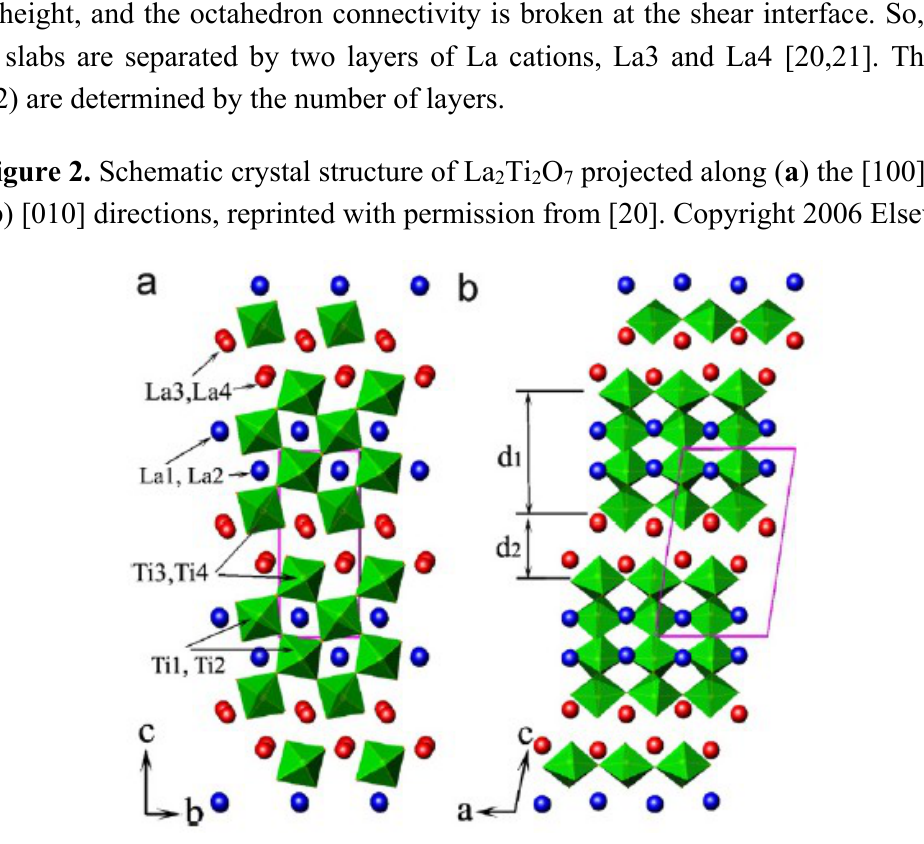
Ti O projected along ( a ) the [100] and 2 2 7